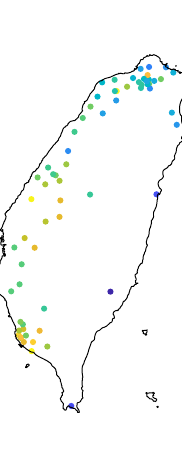
Figure 3. Average extreme PM 2.5 concentration within 96 h for 5-year ( a ) and 100-year ( b ) return periods (unit: μg/m 3 ). 4.2. Heterogeneity of Air Pollution